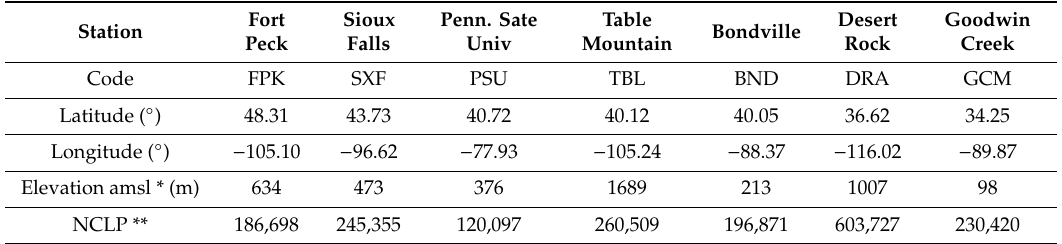
Table 1. Description of the ground-based stations used for the measurement collection, from the northernmost station to the southernmost one.